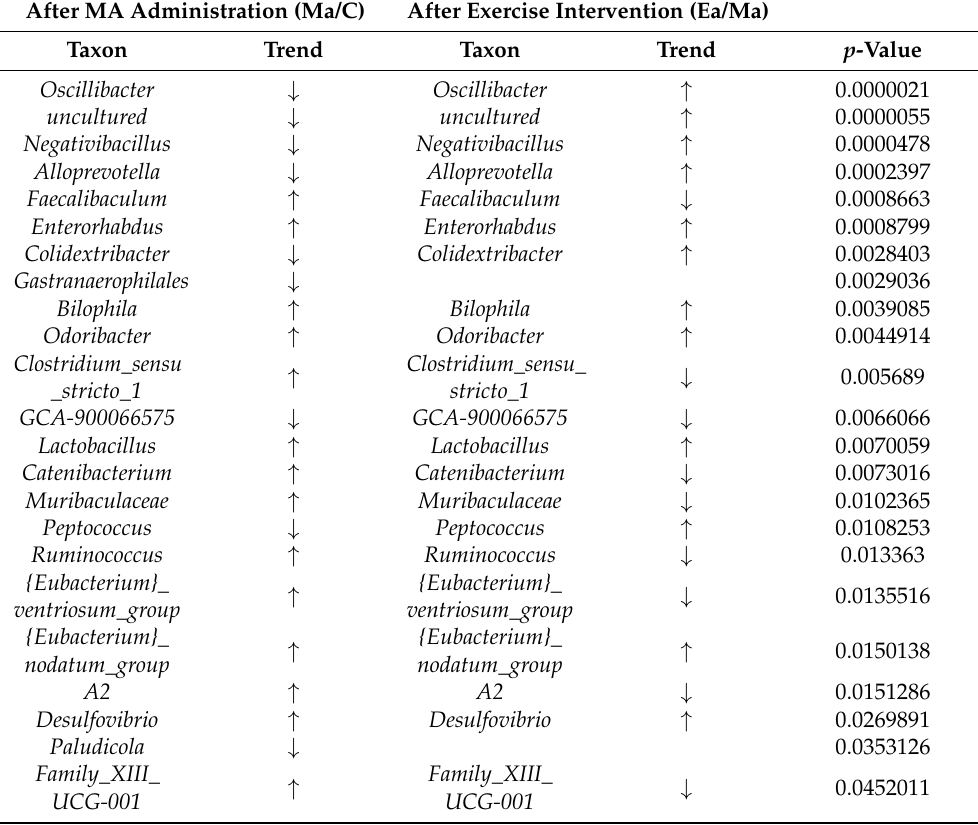
Table 1. Table of the relationship between the changes in genus levels among the three groups of